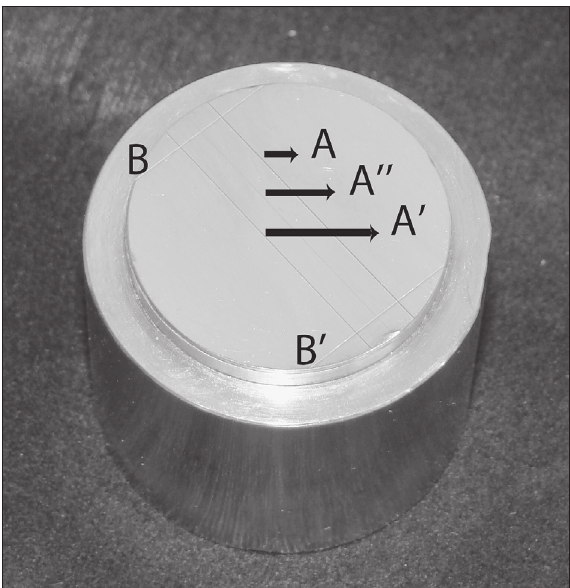
Figure.1.- Upper surface of the stainless steel cylinder, in which the lines A (75 µ m wide), A’ (50 µ m), A” (25 µ m), B and B’ (both measuring 75 µ m in width) may be